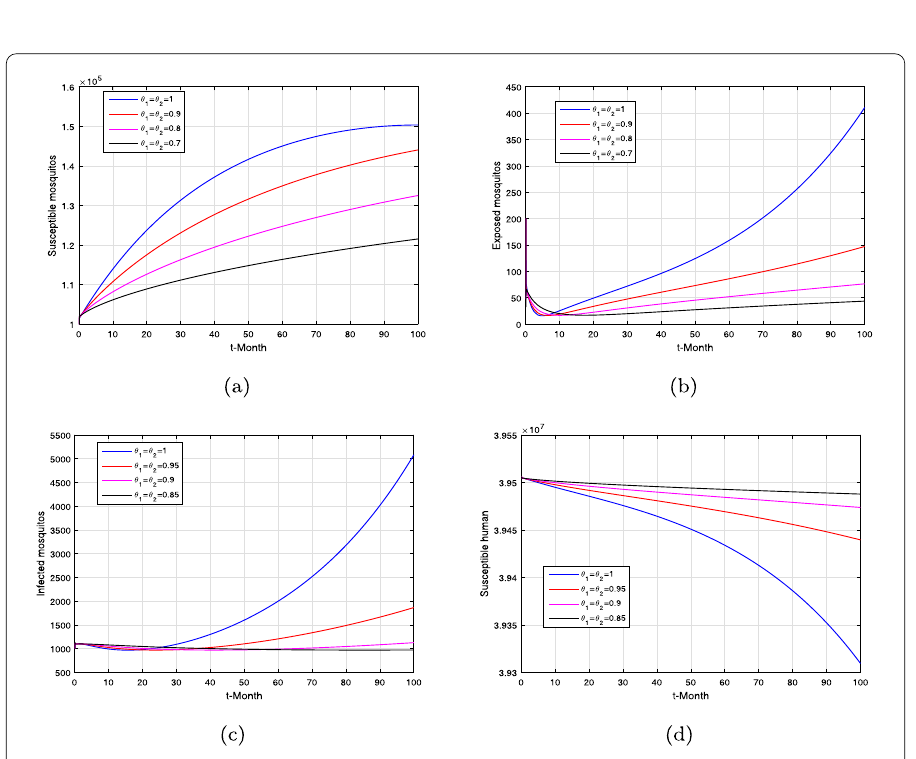
Figure 6 Simulation of the fractal-fractional model (10) when θ 1 = θ 2 = 1,0.9,0.8,0.7 where ( a ) susceptible mosquitos, ( b ) exposed mosquitos, ( c ) infected mosquitos, ( d ) susceptible